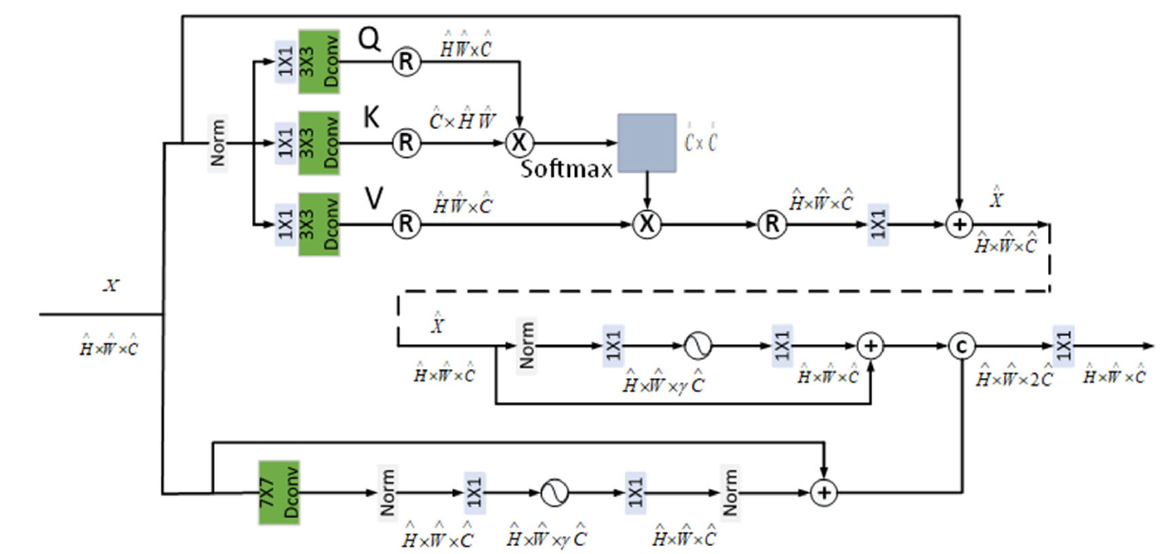
Figure 3. The CNN and transformer structure diagram.